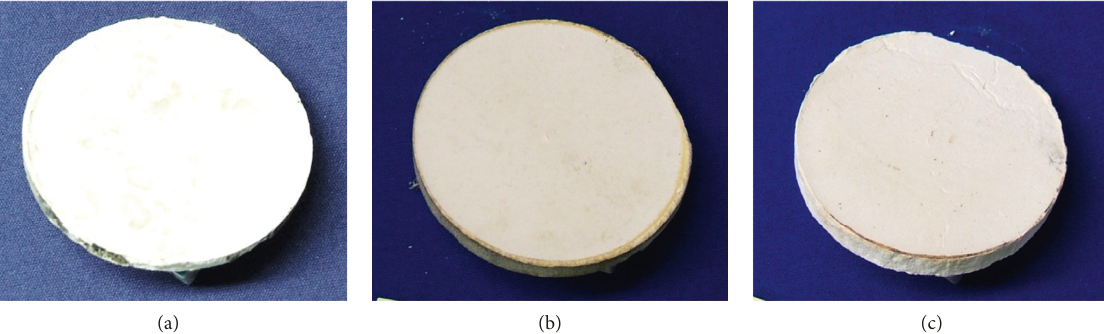
Figure 2: Disc-shaped molded composites obtained by hydrothermal hot pressing of (a) CaCO (b) CaCO 3 -chitosan composite prepared at 95 ° C, and (c) milled scallop shells.